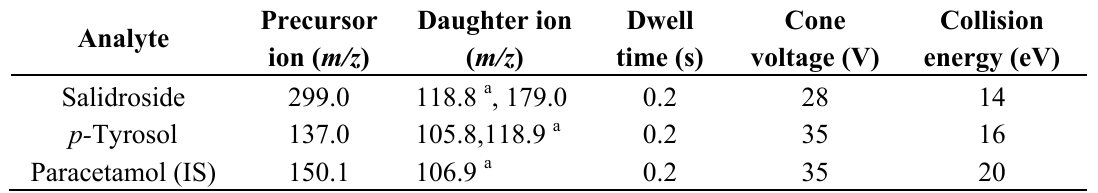
Table 1. ESI-MS/MS parameters for salidroside, p- tyrosol and paracetamol